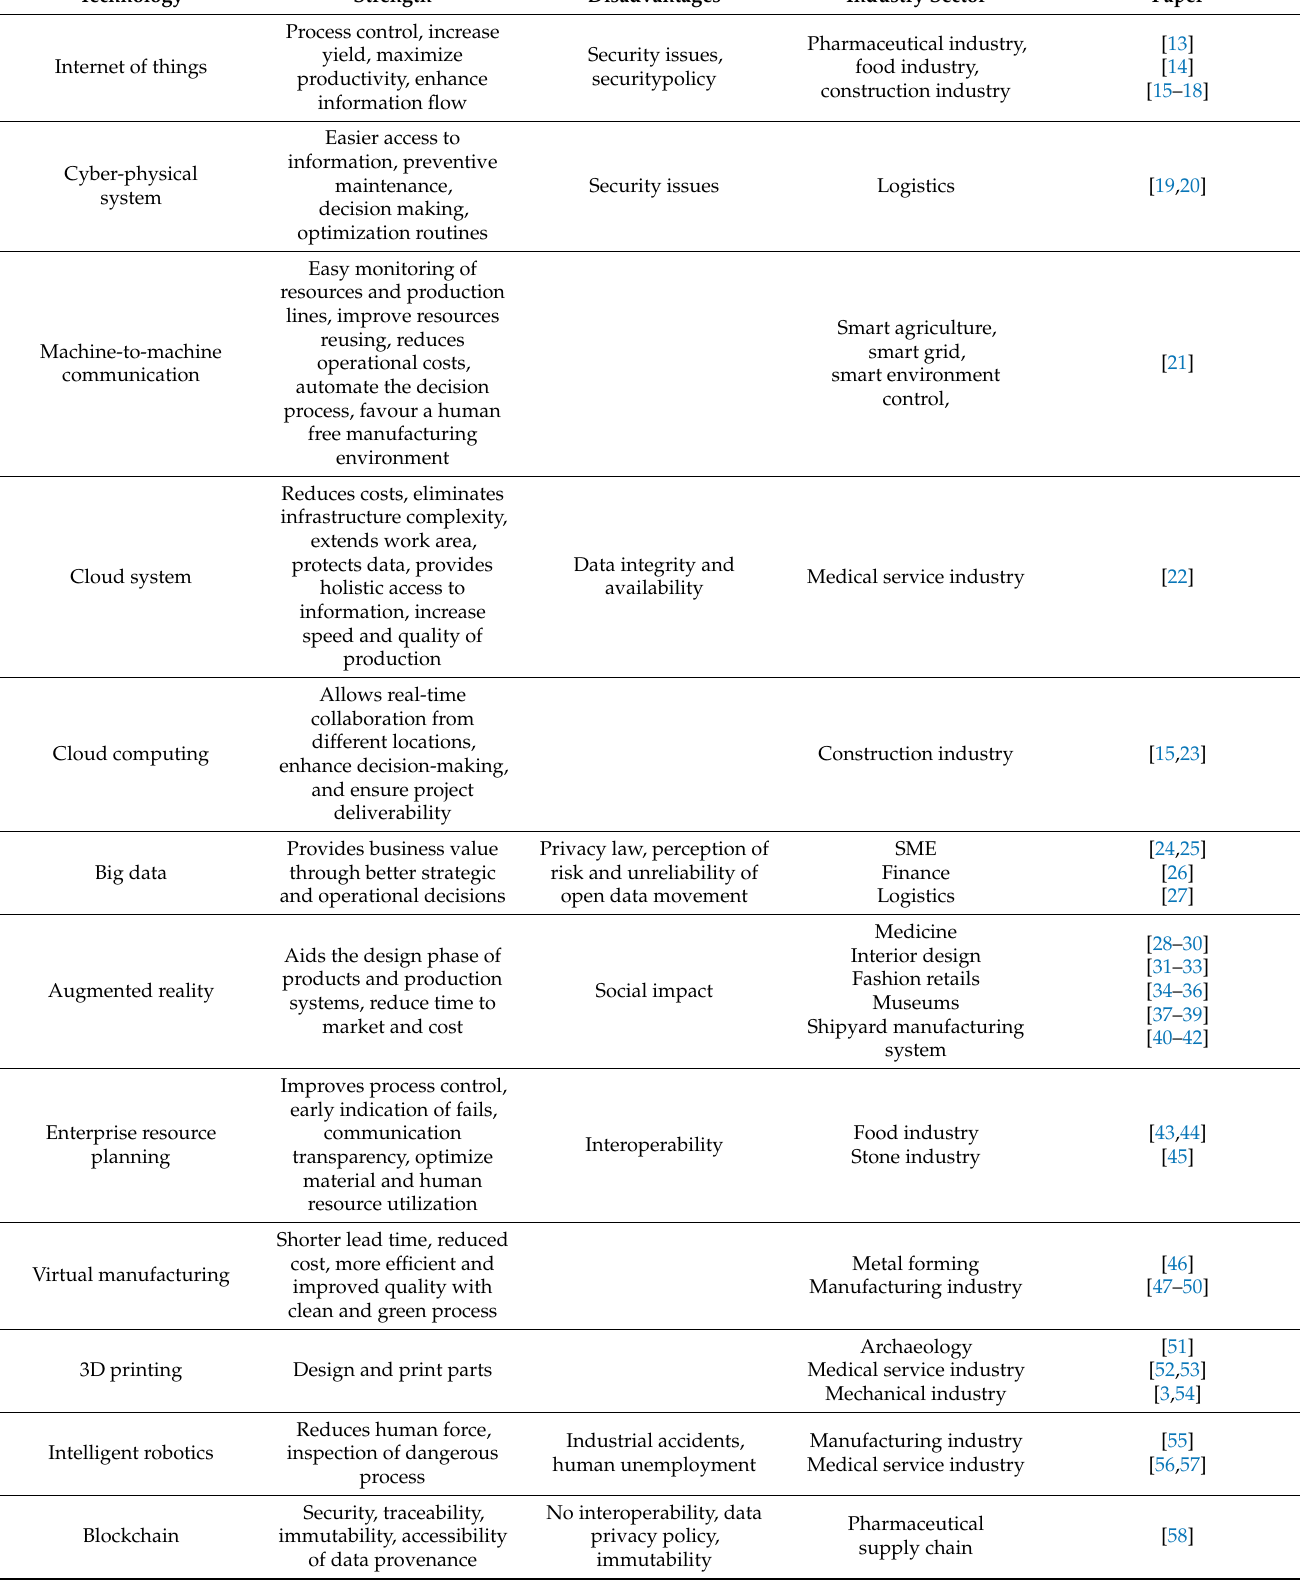
Table 1. Breakdown of the main technologies of I4.0 adopted in different industry